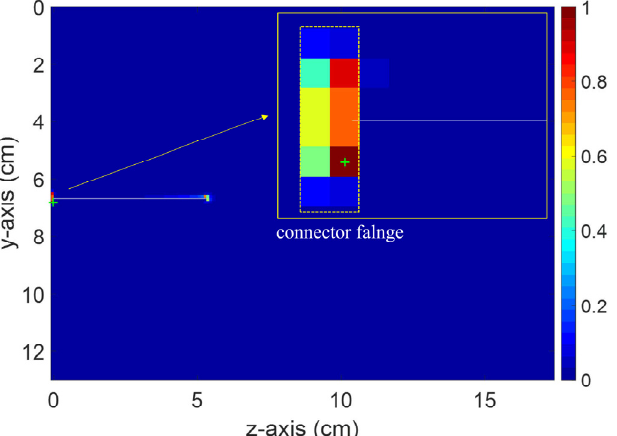
Figure 8. Distribution of the normalized maximum power over the calculation domain in presence of the source monopole antenna (matched media) at cut plane x = 14.78 cm. The solid white line represents the location of the source monopole antenna.